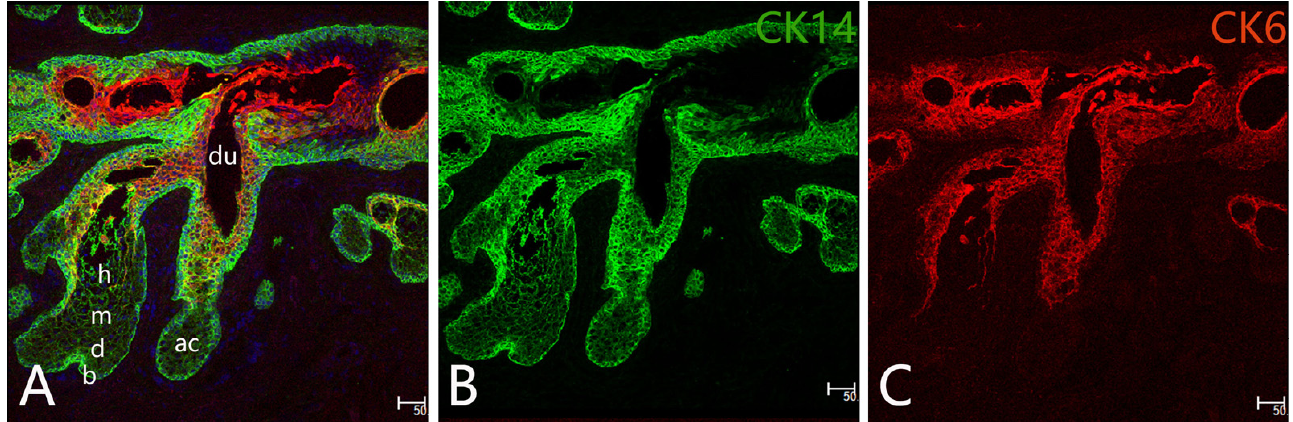
Figure 1. Histology and anatomy of human MG. Structure of the acinar (ac) and ductal (du) system of a normal MG ( A ). The meibocytes go through four maturation stages: basal (b), differentiating (d), mature (m), hypermature (h). Identification of CK14 and CK6 in the MGs ( B , C ): CK14 is observed in both ductal and acinar epithelial cells ( B ), CK6 is only expressed in ductal epithelial cells ( C ).